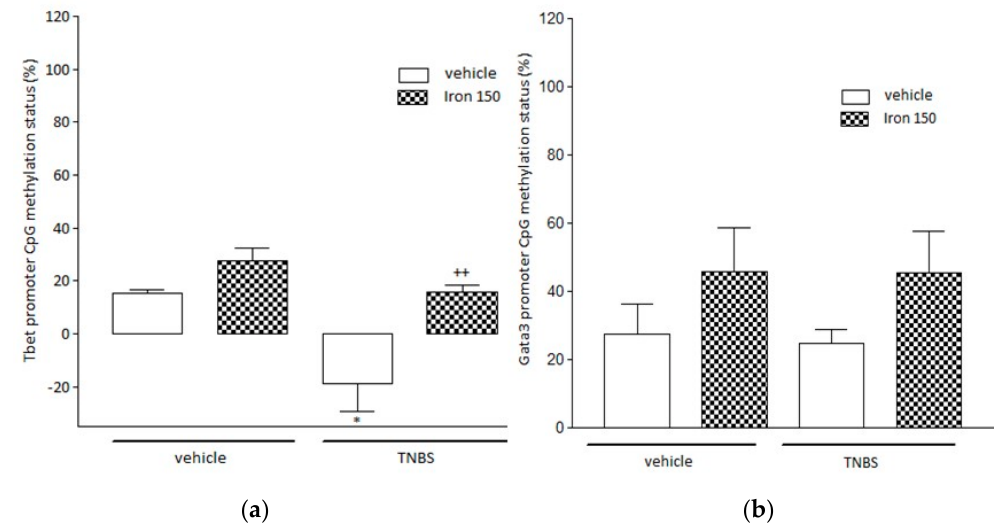
Figure 5. The impact of ferric iron supplementation on the Tbet ( a ) and Gata3 ( b ) promoter CpG methylation status (%). Data are expressed as Mean ± SEM. * Significantly different ( p < 0.05) from vehicle-treated mice. ++ Significantly different ( p < 0.01) from vehicle-treated TNBS mice. White columns: vehicle-treated mice; squared columns: ferric iron (150 mg/kg/g po ) treated mice. TNBS instillation resulted in a significant reduction ( p < 0.001) of the Tbet promoter CpG methylation status (A) which was reversed by iron treatment ( a ). By contrast, we did not observe any modification of the methylation status of the promoter region of Gata3 ( b ) regardless of whichever treatment was considered.